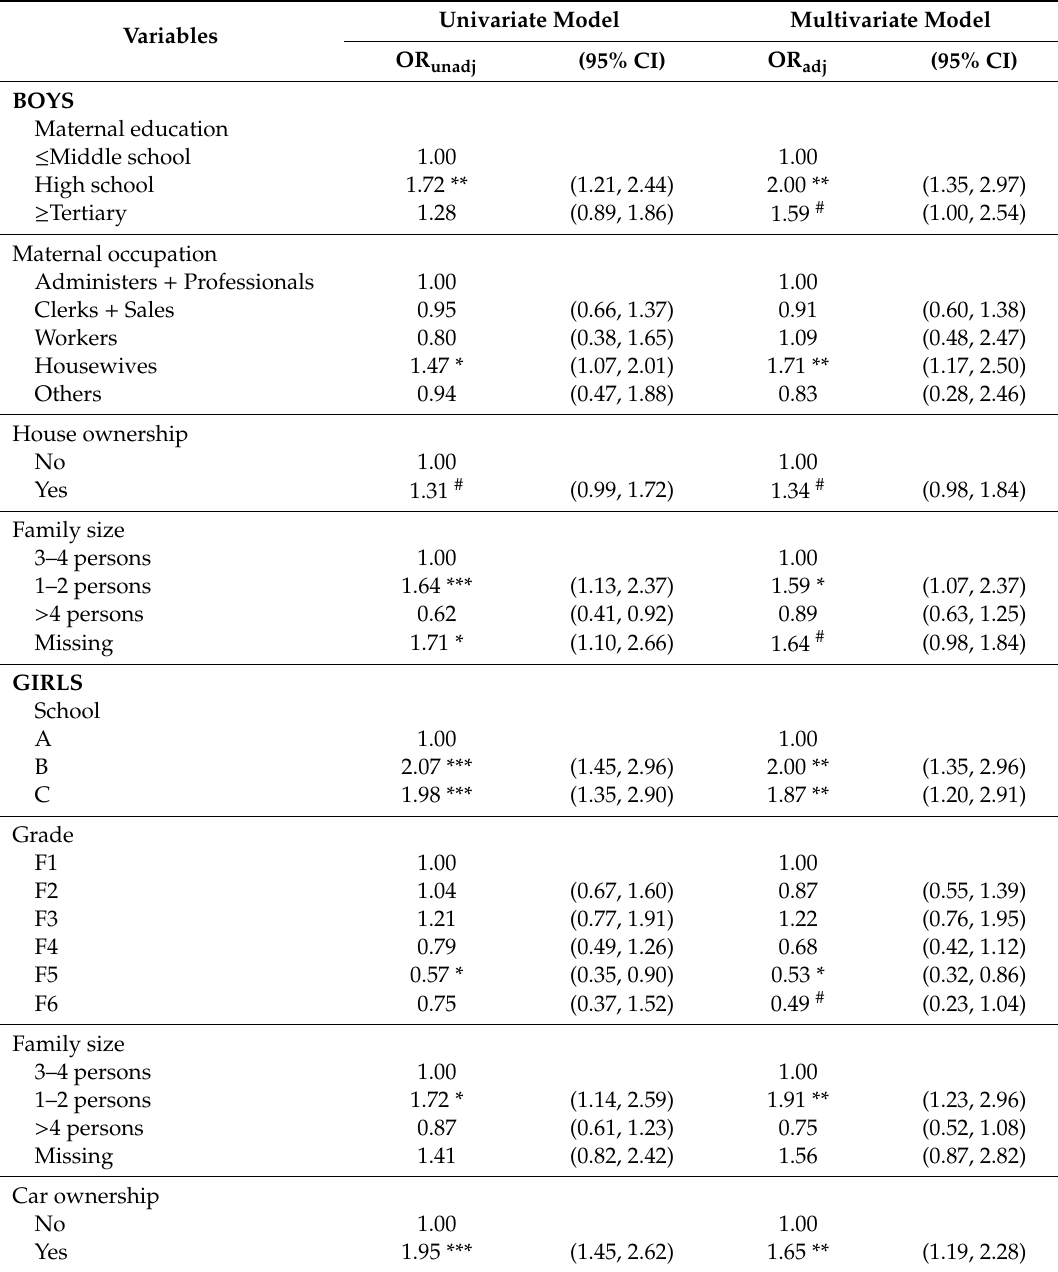
Table 2. Risk estimates of sociodemographic characteristics for PARIs by